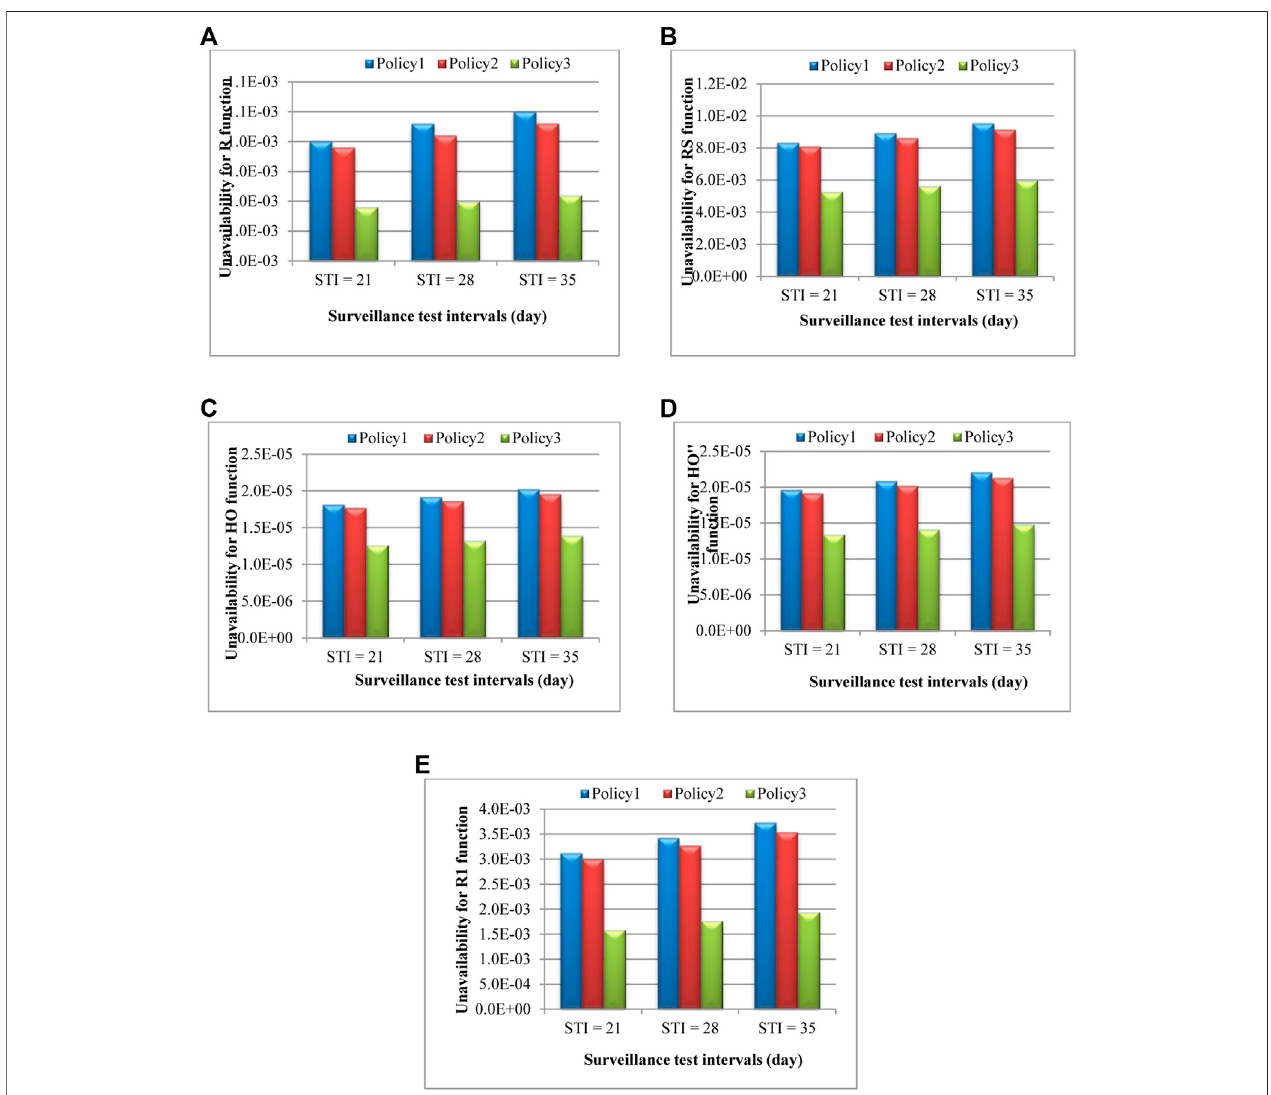
FIGURE 10 | Comparison of unavailability between different STIs and three maintenance policies for functions of “ Emergency Cooling System ” : (A) R, (B) RS, (C) HO, (D) HO ″ , (E) R1.